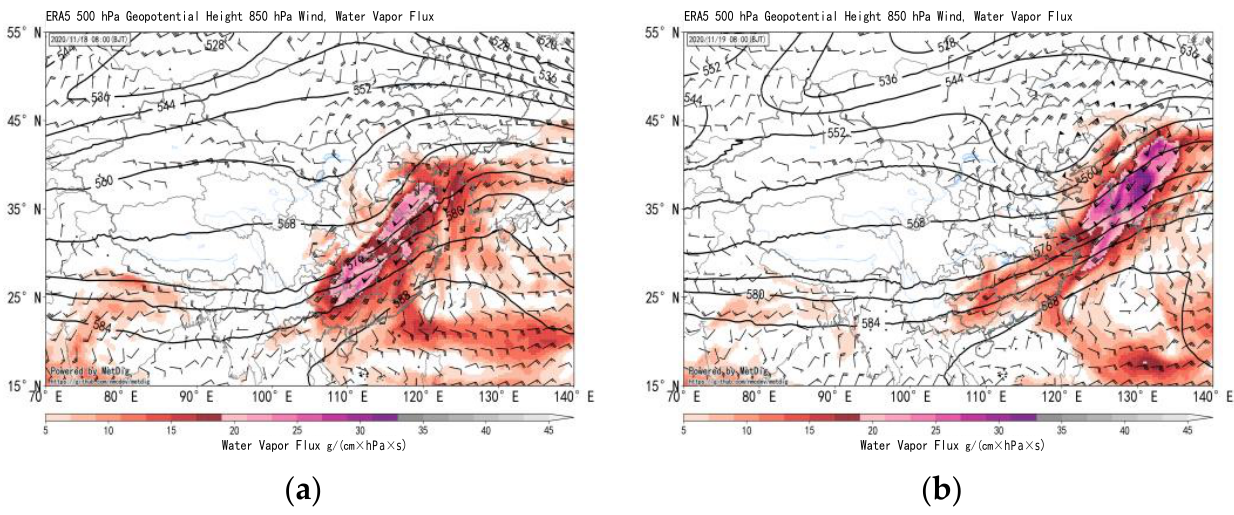
Figure 7. ( a ) 850 hPa water vapor flux (color) and wind field (arrow) at 08:00 on 18 November, ( b ) 850 hPa water vapor flux (color) and wind field (arrow) at 08:00 on 19 November.